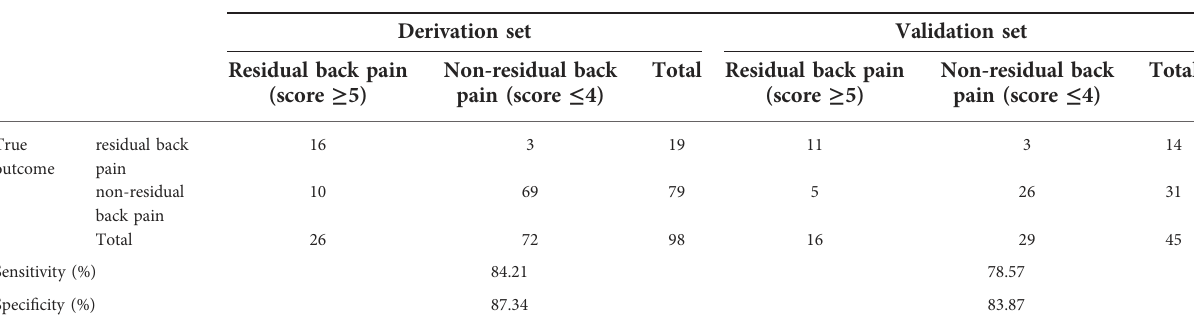
TABLE 4 Comparison of performance of the scoring system on derivation set and validation